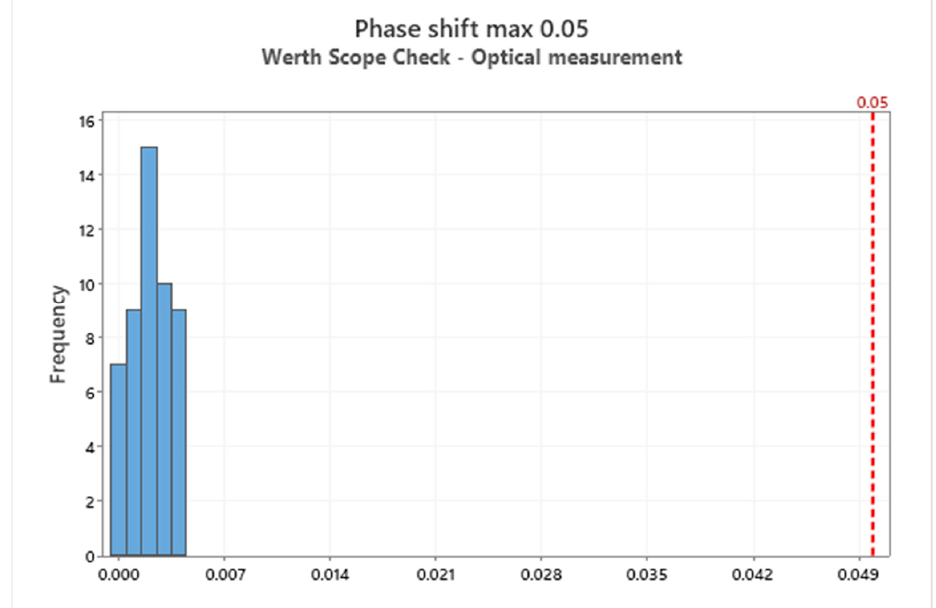
Figure 16. Tooth phase shift max. 0.05—histogram from measurements obtained with the Multisensory Measuring Machine Werth Scope Check, values on x axis given in mm (own study).